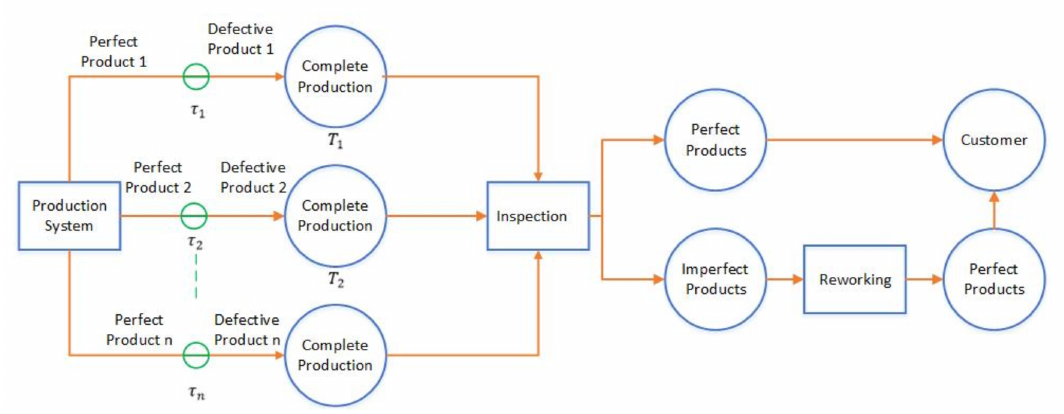
Figure 1. Process flow for multi-product production